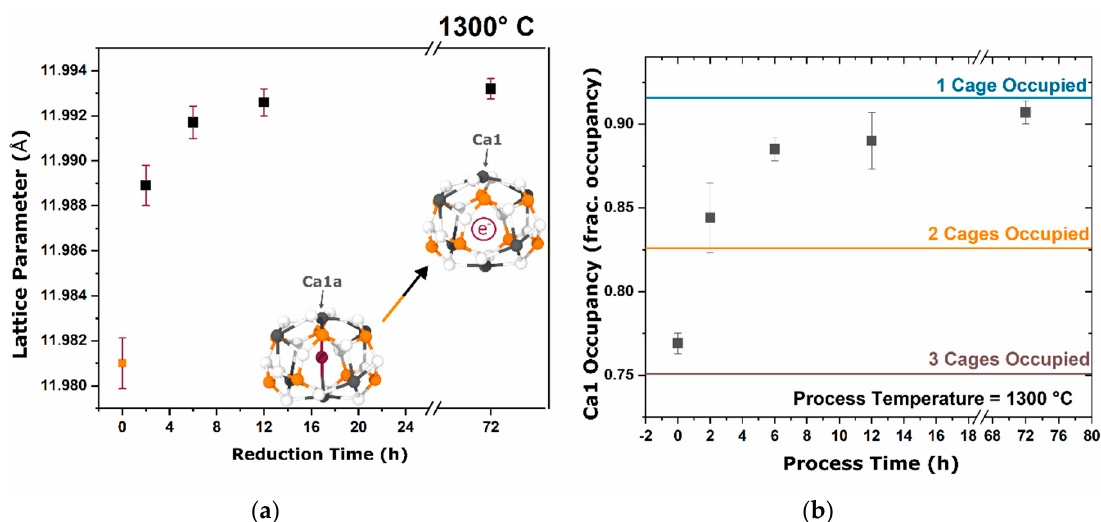
Figure 7. ( a ) Refined lattice parameter of oxy-C12A7 reduced at 1300 ◦ C for various process duration times. The lattice parameter continued to increase as processing time was increased. Inset shows how the contracted occupied cages expanded and the cage dimension increased when cages lose their occluded molecular species, resulting in an increased lattice parameter. Error bars are reported as 3 σ . ( b ) Refined Ca1 (unoccupied cage) site occupation. Error bars are reported as σ .